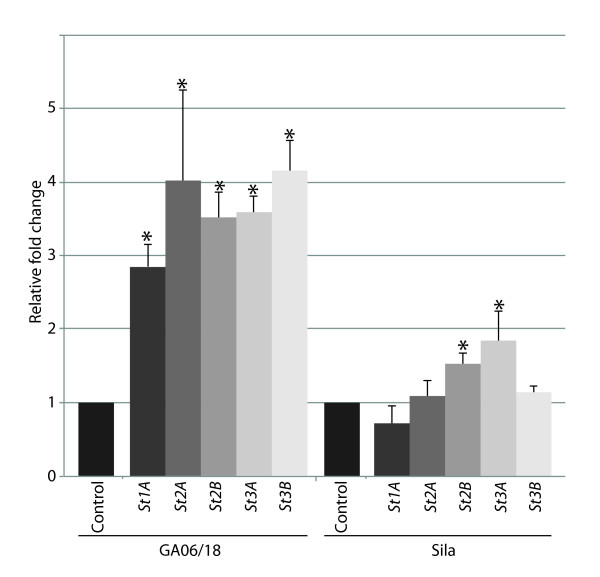
Relative qPCR values of St1A, St2A, St2B, St3A and St3B transcripts in sorghum GA06/18 and Sila plants inoculated with S. turcica, 24 hpi. Water treatment was used on respective genotypes as a control. Error bars indicate standard deviation between three biological replications. * Indicates a significant increase (P < 0.05) compared to control levels. Primer used listed in Additional file 2.